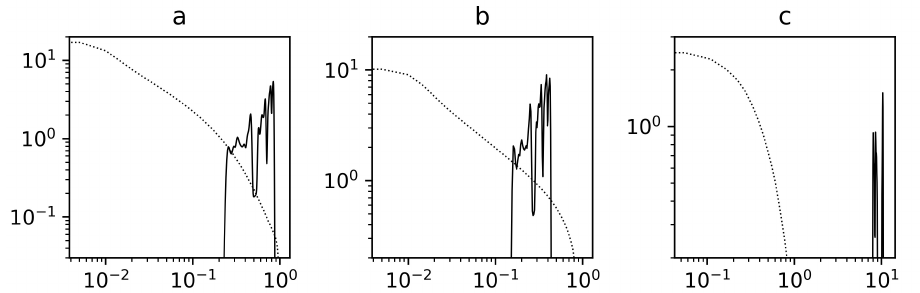
Figure 4. Probability distribution of the maxima of 1 − x (Panel a ), y (Panel b ), z (Panel c ), in case of non-intermittent dynamics (solid line) and for on–off intermittent behavior (dotted